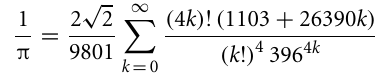
Table 2: Scan-time equation numbers by subject, session and trial Table 3: Scan-time beauty ratings for each equation by subject Table 4: Scan-time beauty ratings by subject, session, and trial Table 5: Scan-time beauty ratings by subject—Session and experiment totals Table 6: Post-scan understanding ratings by subject Table 7: Post-scan understanding ratings by subject, session, and trial Table 8: Post-scan understanding ratings by